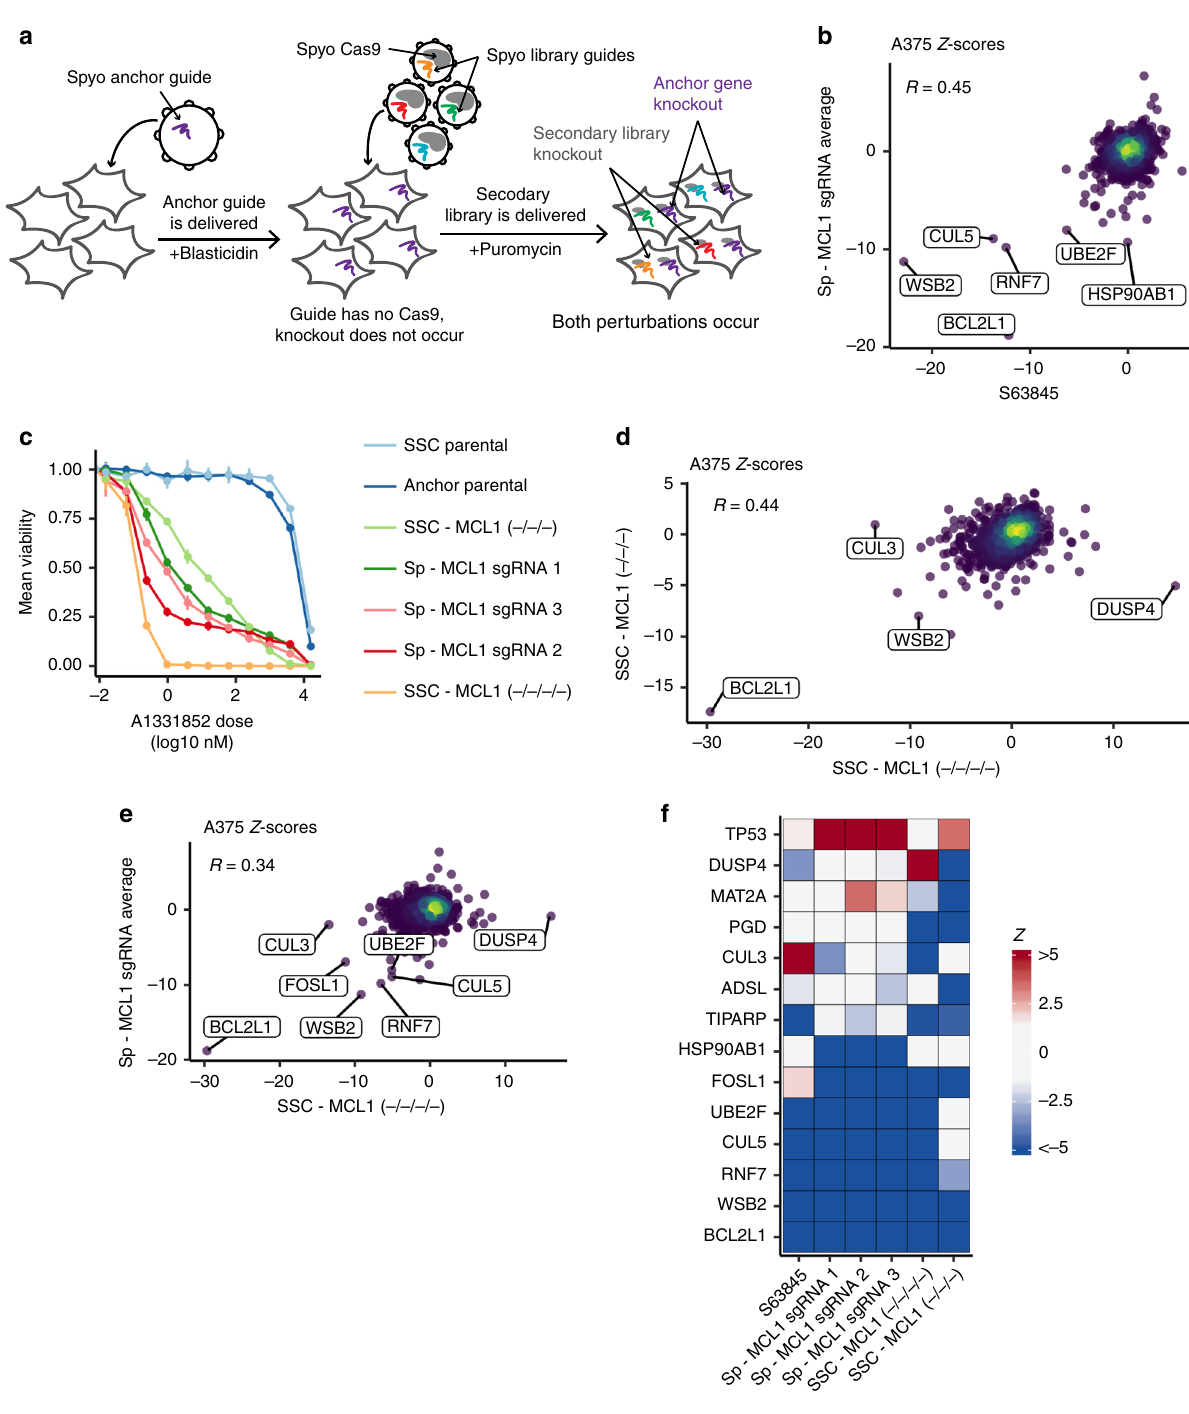
Fig. 4 MCL1 secondary screens comparing alternative screening approaches. a Schematic of Spyo-only approach screened with the secondary library. Spyo anchor perturbation shown in purple, Spyo library perturbations shown in remaining colors. b Z -scores for MCL1 anchors, averaged across three guides compared to S63845 treatment, screened with a secondary library in A375 cells. Points are colored by density. Pearson correlation coef fi cient is indicated. Top six hits, ranked by average absolute Z -score across MCL1 guide conditions, are labeled. c Dose response curves for cells treated with A-1331852. Cells include two A375 parentals, two A375 MCL1 knockout clones, and three A375 MCL1 anchor knockouts. The line range represents one standard deviation for doses where multiple viability measurements were collected. d Same as b but for the MCL1 − / − / − knockout clone vs the MCL1 − / − / − / − knockout clone. Top two hits ranked by absolute average Z -score and top two differences between single-cell clone conditions are labeled. e Same as b but for MCL1 anchors, averaged across all guides vs the MCL1 − / − / − / − knockout clone. Top six and fi ve hits ranked by absolute average Z -score for MCL1 guide conditions and the MCL1 − / − / − / − knockout clone, respectively, are labeled. f Heatmap of Z -scores for the top fi ve hits from all secondary screens, ranked by absolute Z -score. Genes and screens are ordered by mean Z